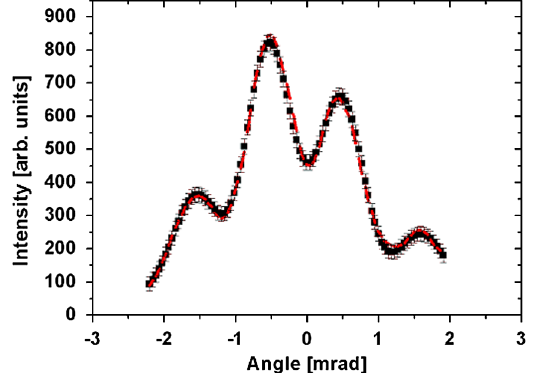
FIG. 11. ODRI angular distribution of a beam going through the center of the second slit. Both experimental data (black squares) and a fit curve, based on theoretical model (red dashed line), are shown.